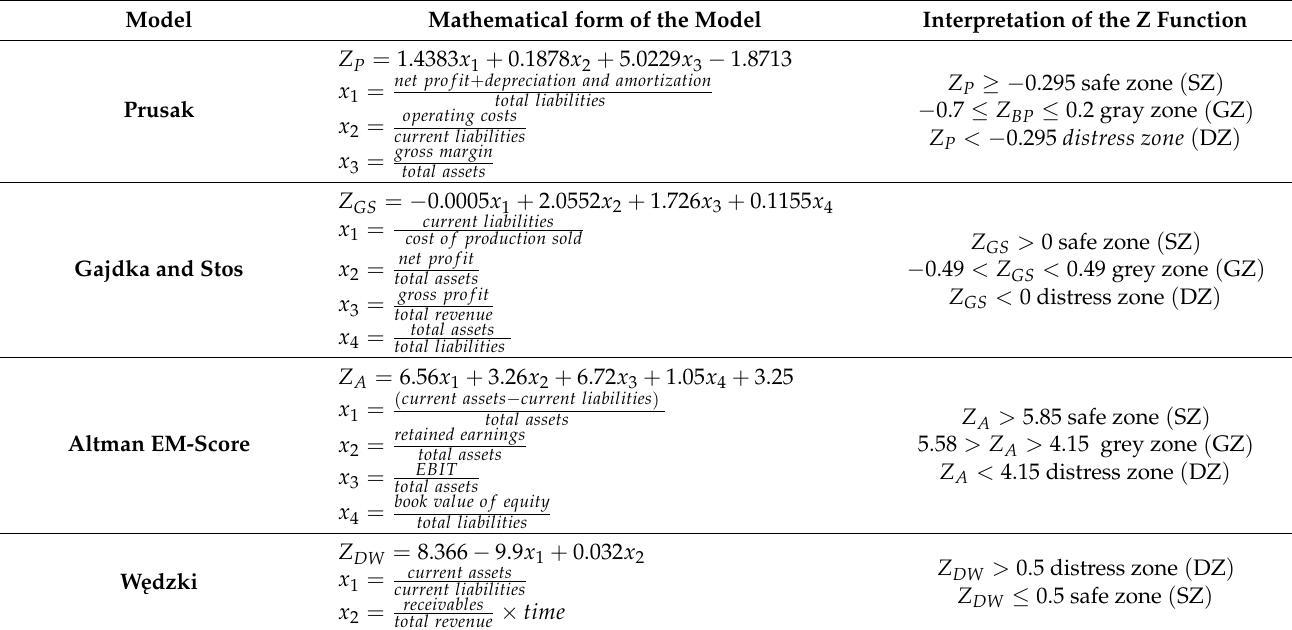
Table A1. The mathematical form of the models and the interpretation of the Z function.